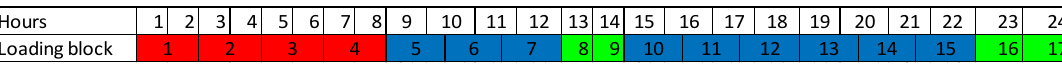
Figure 7. Discretization in 17 loads in the SMG.